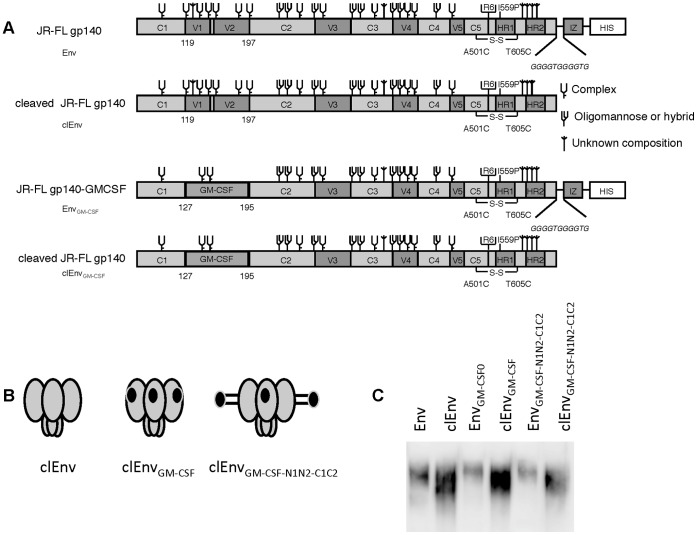
Schematic and expression of the cleaved and linker extended EnvGM-CSF.Linear (A) and cartoon (B) representation of the Env, clEnv, EnvGM-CSF and clEnvGMCSF proteins. Cleaved versions were created by introducing a stop codon in front of the isoleucine zipper (IZ) trimerization domain in the EnvGM-CSF0, EnvGM-CSF-N1N2-C1C2 and Envwt constructs. C. Expression of chimeric cleaved EnvGMCSF constructs.